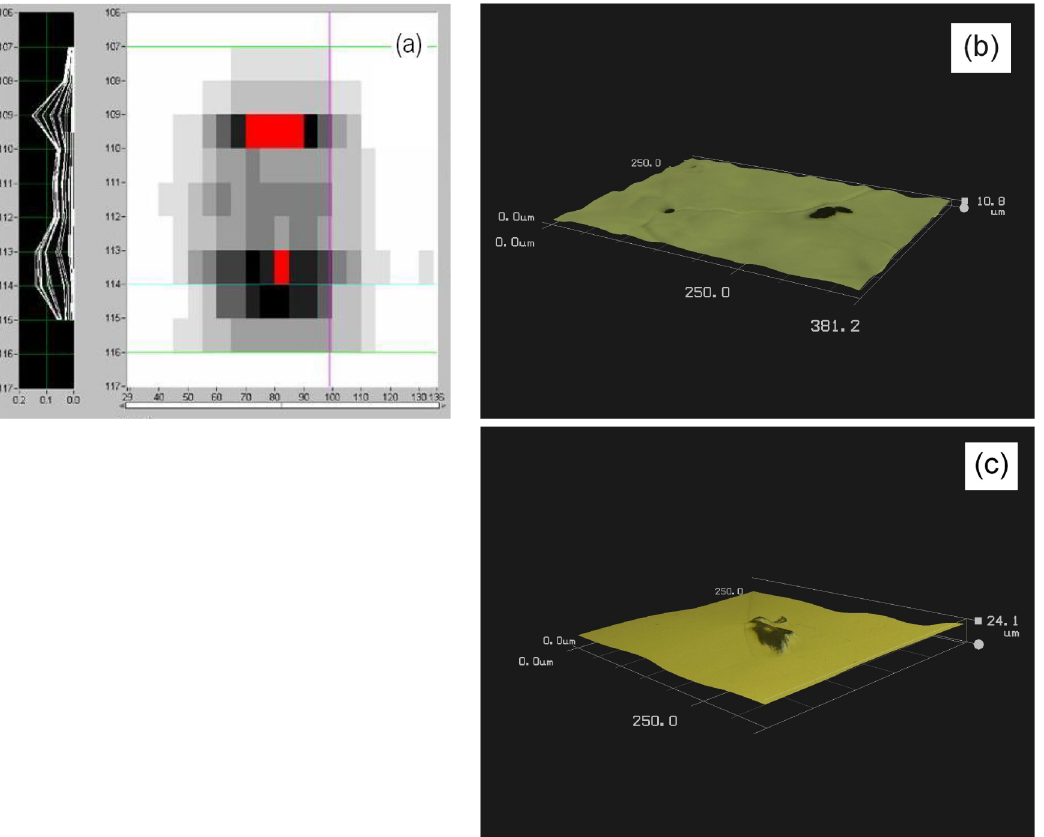
FIG. 3. (a) T-map for (cid:2) mode with hot spots in the equator area of cavity Z130 and away from the equator caused quench at 16 MV =m ; (b), (c) images of defects detected in the hot-spot areas shown in (a).